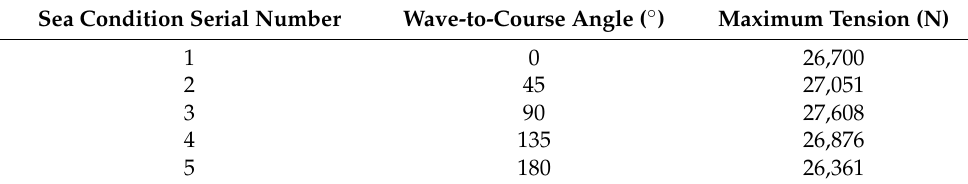
Table 6. Maximum tension required for tensioner support under various sea